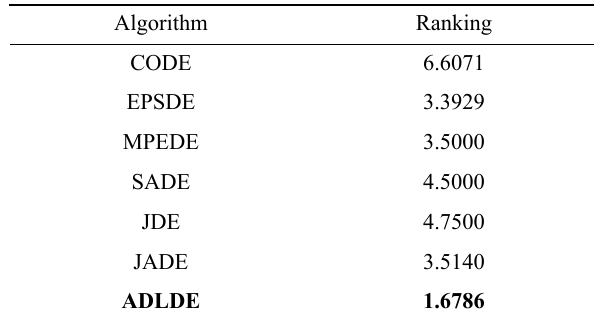
Table 8 Friedman test ranking when D = 30.